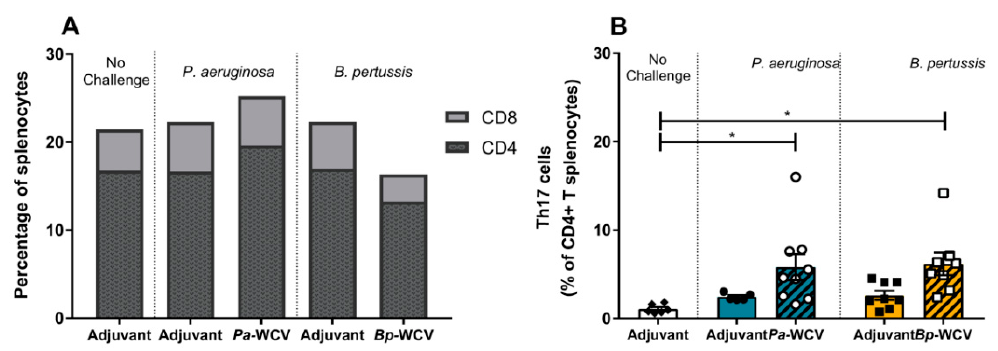
Figure 6. Whole cell vaccination leads to increase in Th17 cell populations within splenic T cells. ( A ) The frequency of CD4 + (CD3e + CD4 + ) or CD8 + (CD3e + CD8 + ) T cells in splenocytes at day 7 post-infection ( n = 5–9 per group). ( B ) The proportion of Th17 cells (CD3e + CD4 + Ror γ T + ) within the CD4 + T cell population. The asterisks indicate statistical significance determined by ANOVA: * p ≤ 0.05.